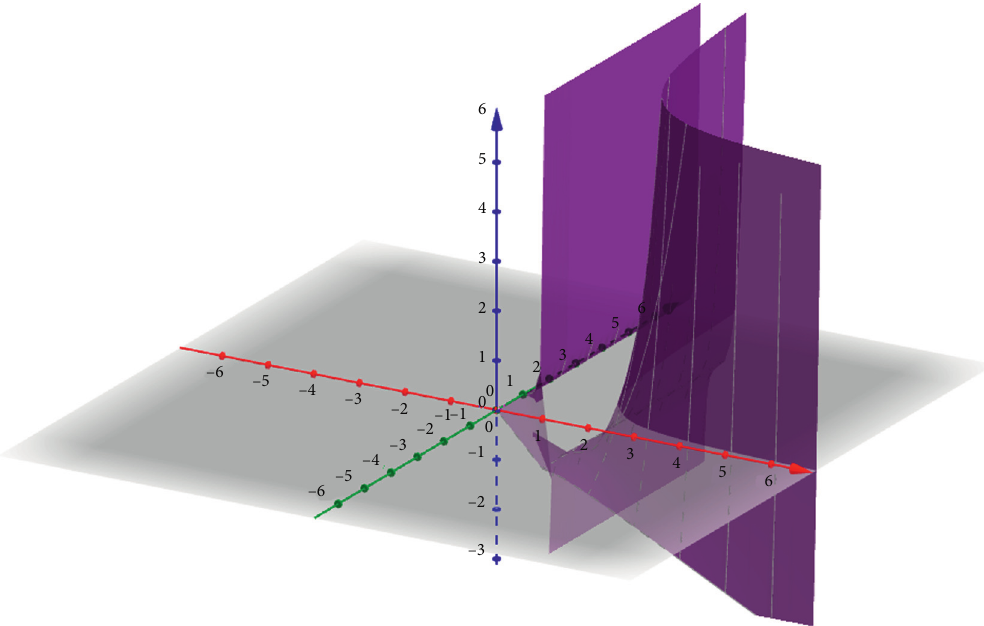
Figure 5: Inverse sum index of ( S k